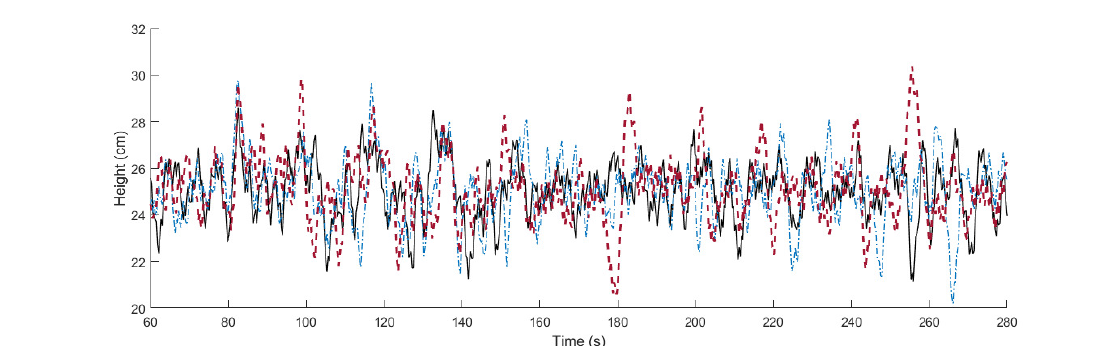
Figure 9. Output response of the air levitation system in the disturbance rejection experiment. Solid black line: proposed algorithm. Dot-dashed blue line: algorithm in [30]. Dashed red line: auxiliary PI